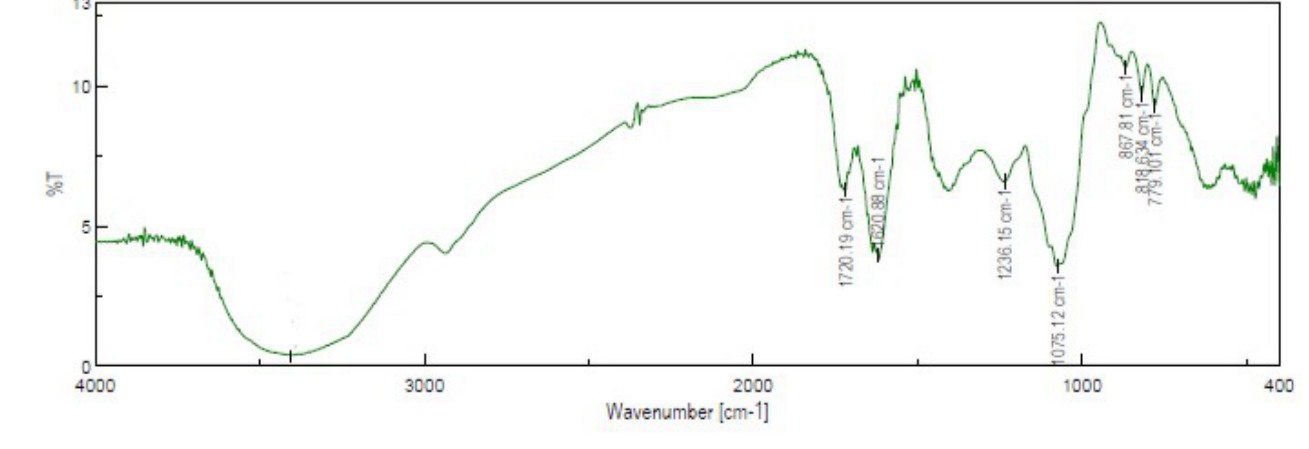
Figure 2. FT − IR spectrum of RCL extract.